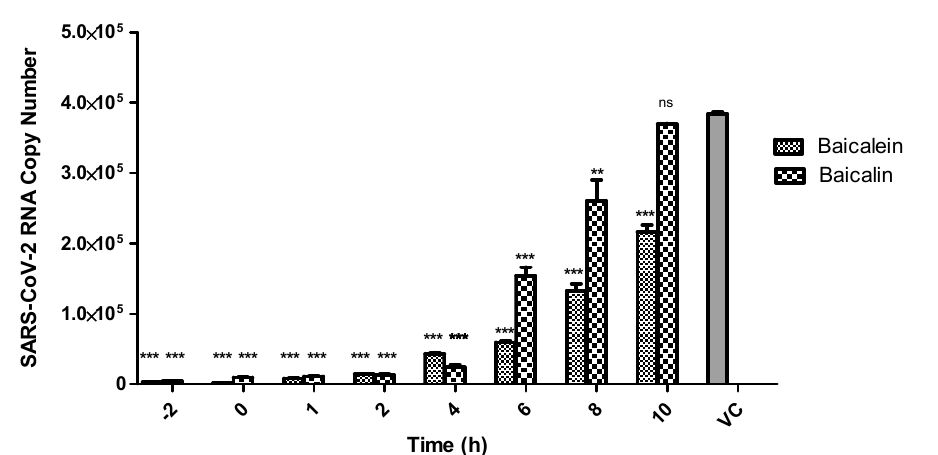
Figure 3. Time-of-addition assay. The effects of baicalein and baicalin on SARS-CoV-2 in vitro replication were assessed at different time points of compound addition. A single concentration of each compound based on EC 90 value of the compound was added to the respective wells from 2 h prior infection up to 10 h post infection. Data for each time point were analyzed independently to the virus control via two-way ANOVA analysis using GraphPad Prism 7 for Windows. The results are presented as means ± standard error whereby p < 0.01 was represented as **, p < 0.001 as *** and nonsignificant readings were labelled as ns.